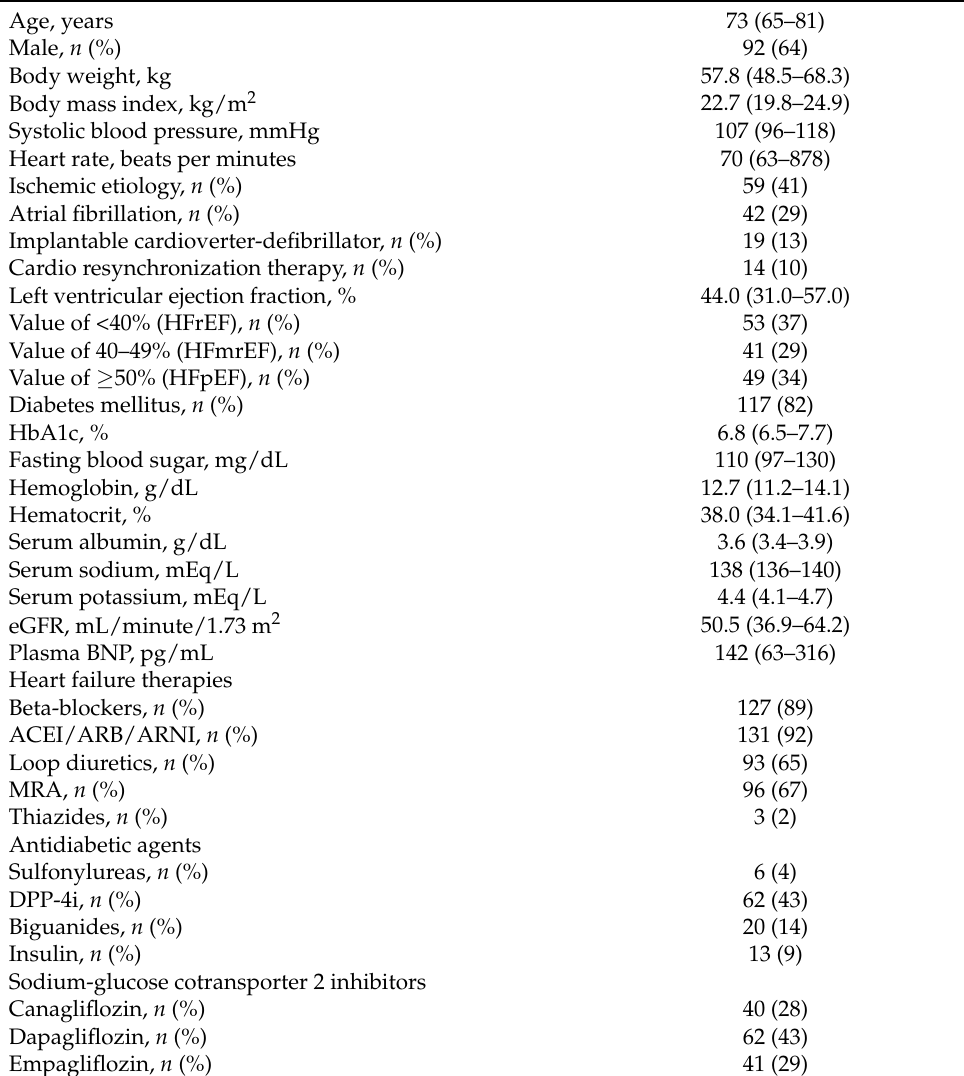
Table 1. Baseline